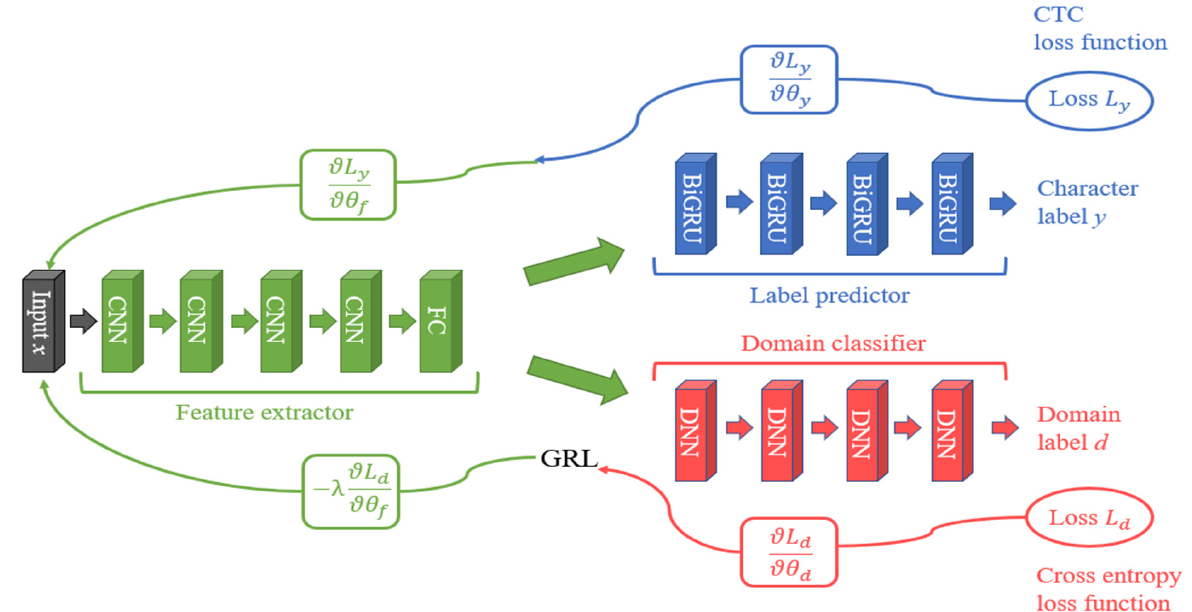
Figure 4. Model training framework for end-to-end domain adversarial training based on DANN.